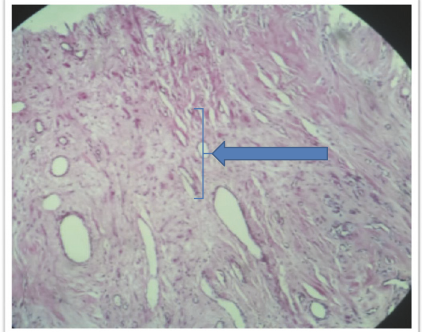
Figure 5: Microsection shows tumor tissue fragments comprised of abundant fibrous tissue (arrow heads) having benign proliferating spindle cells, myxoid areas, and proliferating dilated blood vessels in